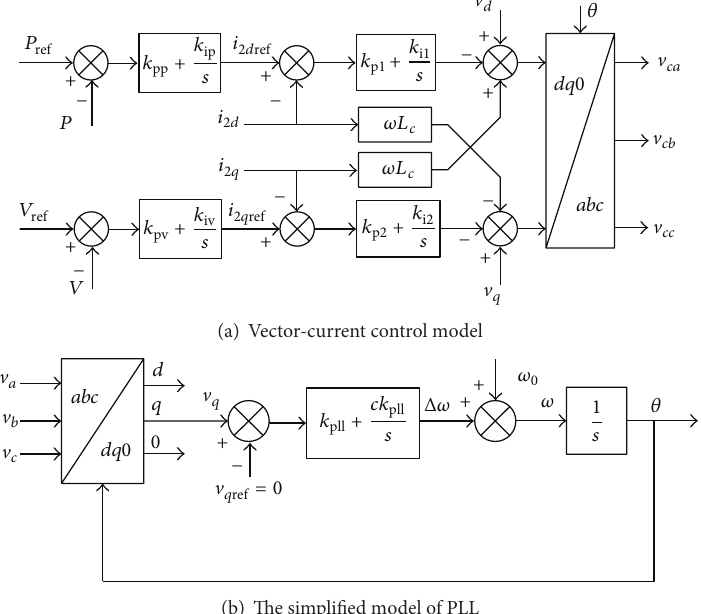
(b) The simplified model of PLL Figure 2: Control diagram of VSC connected to weak AC system.